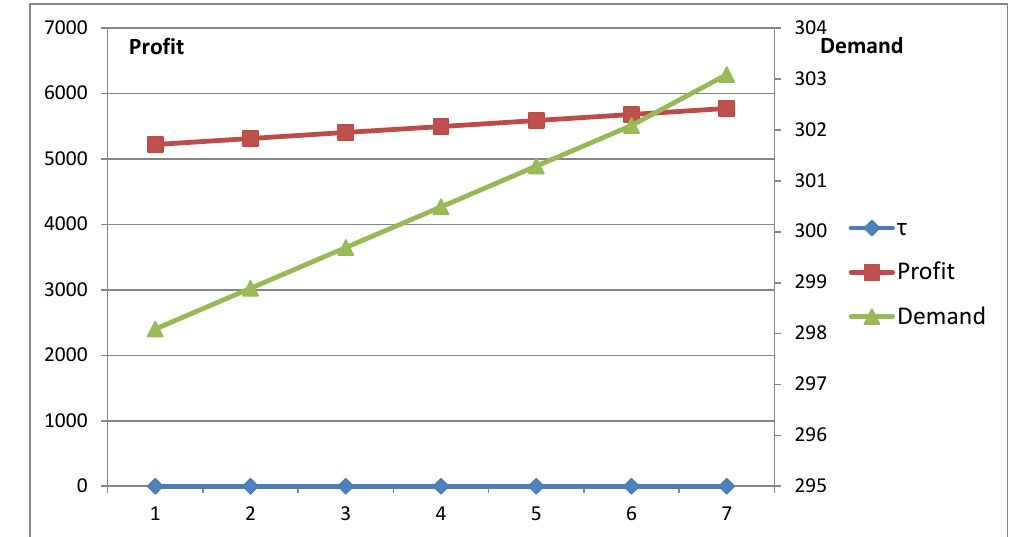
Figure 4. Profit vs. demand with respect to τ .